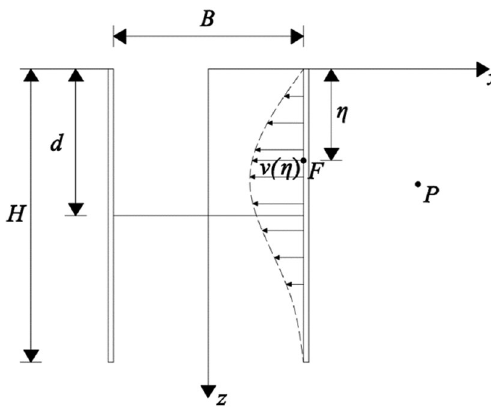
Figure 6. Calculation model of virtual image